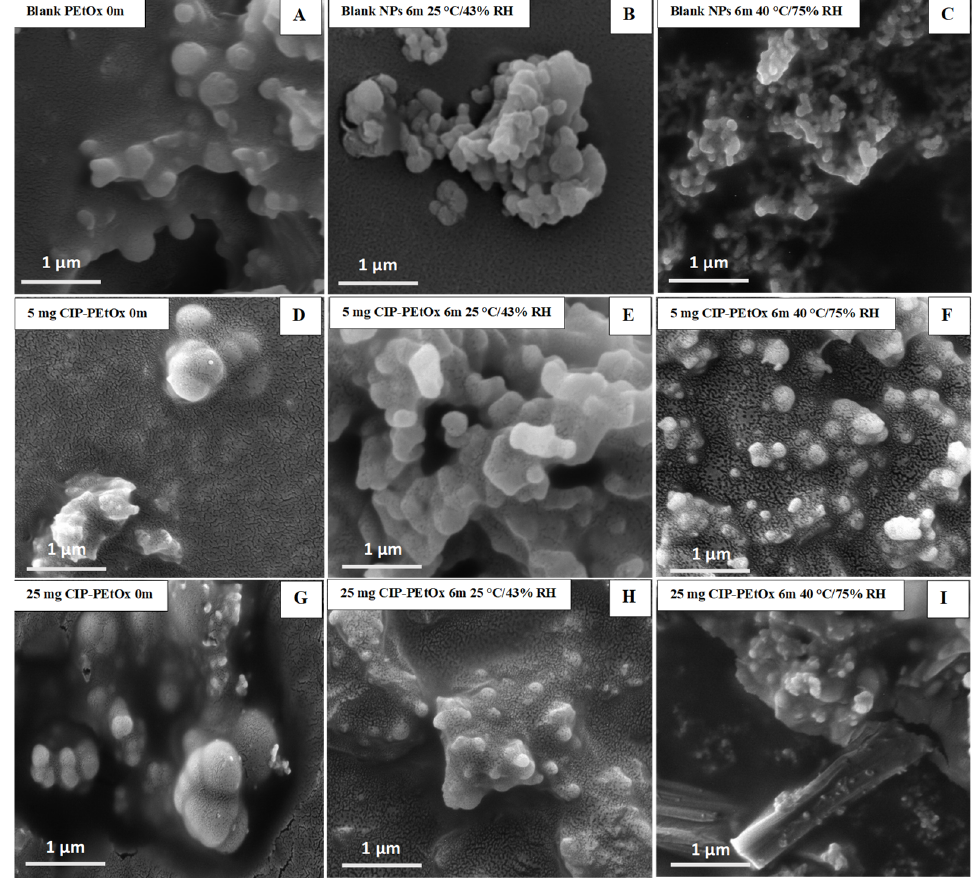
Figure 3. SEM images of blank and CIP-loaded PEtOx NPs before (0 m) and after storage for six months (6 m) at 25 °C/43% RH and 40 °C/75% RH; ( A – C ) blank PEtOx NPs; ( D – F ) 5 mg CIP-loaded PEtOx NPs; ( G – I ) 25 mg CIP-loaded PEtOx NPs.